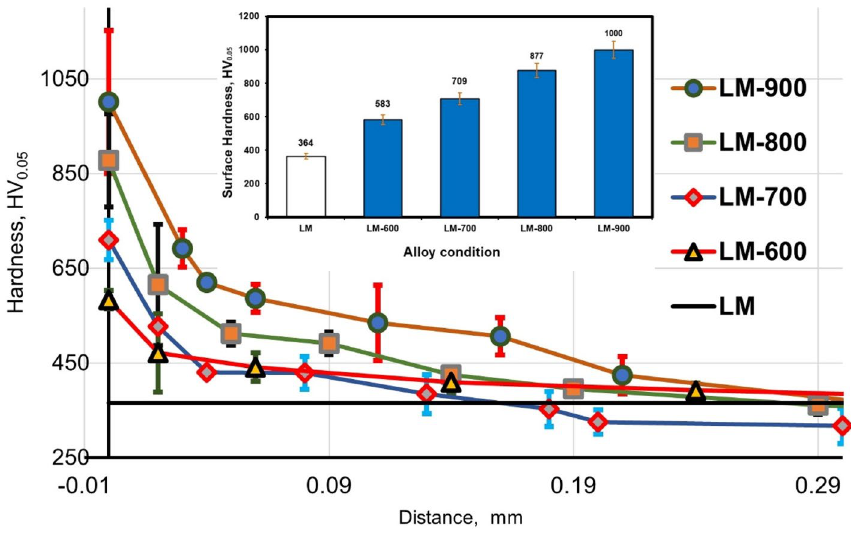
Figure 11. Variation of surface and depth hardness with oxidation parameters for raw and oxidized specimens.